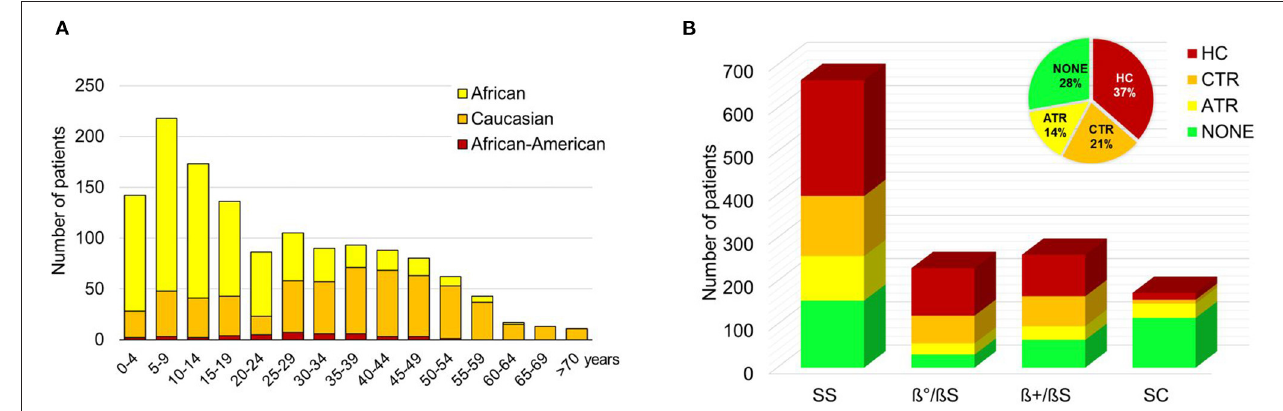
FIGURE 1 | (A) Distribution of sickle cell disease (SCD) patients by age and ethnicity. Data are shown as a column chart that reports, for each age group, the number of Africans and Caucasians patients of the cohort. (B) Distribution of SCD patients by genotype and therapy. Data are shown as a column chart that reports, for each genotype, the number of patients that received HC/ATR/CTR/NONE as their therapy regimen. ATR, acute transfusion; CTR, chronic transfusion; HC, hydroxycarbamide.